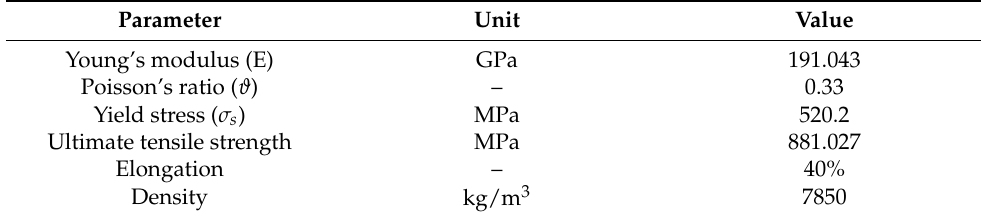
Table 2. Properties of SUS301L–ST.